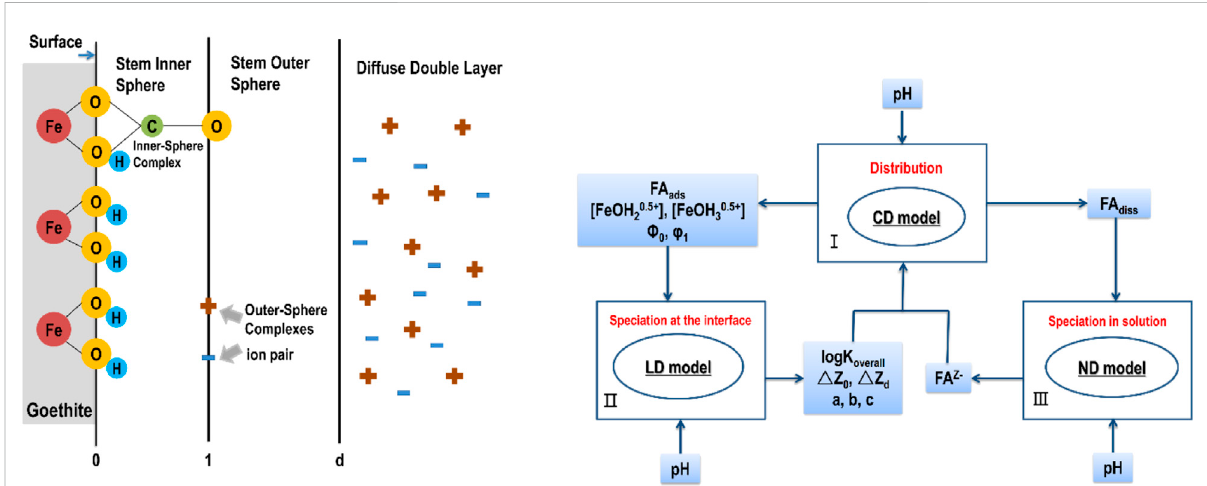
FIGURE 4 Conceptual models of the LCD. (I) The CD-MUSIC model calculates the distribution of organic molecules in solid and solution phases. (II) The LDmodelcalculatestheaverageadsorptionmodeofadsorbedorganicmolecules,whichdeterminestheinputparametersoftheCD-MUSICmodel. (III)TheamountofdissolvedFAisconvertedtothereferencematerialFA z − ,whichisusedastheinputoftheCD-MUSICmodel.Theaf fi nityconstants (logK overall ),chargedistributions( δ Z 0 , δ Z 1 ),stoichiometriccoef fi cients(a,b,c),andFAactivityinsolution(FA z − )wereinputparametersoftheCD-